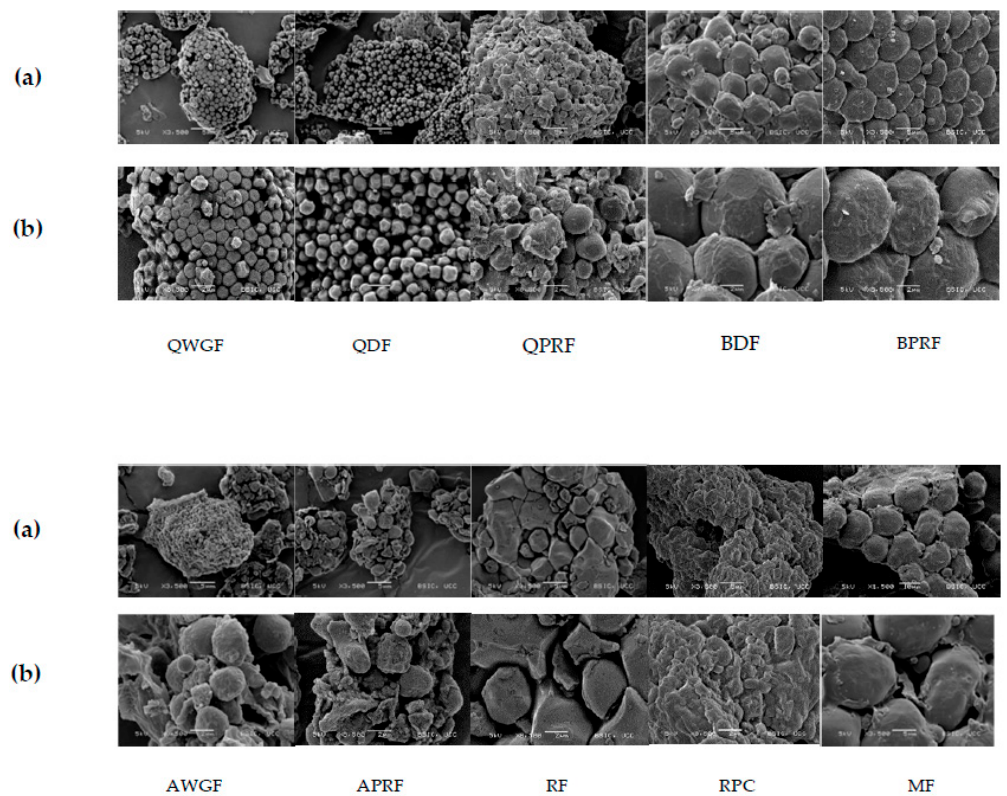
Figure 4. Scanning electron micrographs of quinoa wholegrain flour (QWGF), quinoa dehulled flour (QDF), quinoa protein-rich flour (QPRF), buckwheat dehulled flour (BDF), buckwheat protein-rich flour (BPRF), amaranth wholegrain flour (AWGF), amaranth protein-rich flour (APRF), rice flour (RF), rice protein concentrate (RPC), and maize flour (MF). Magnification row ( a ) ×3500; ( b ) ×8500. Scale bars row ( a ) 5 µm; ( b ) 2 µm.